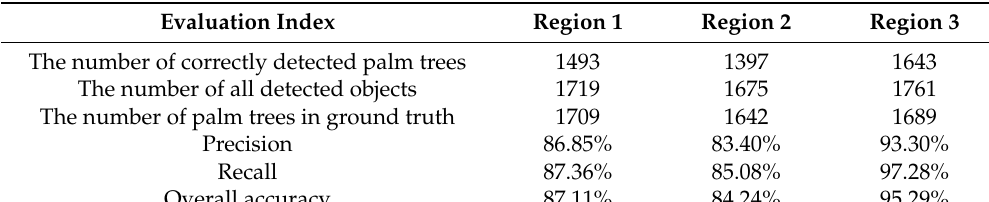
Table 4. Detection results of local maximum filter (LMF).